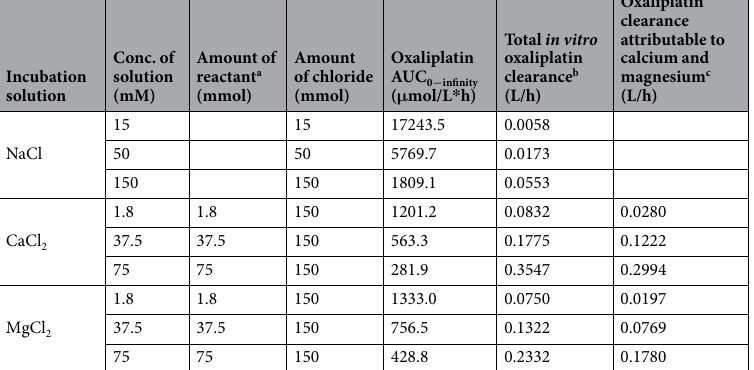
Table 2. Calculation of the in vitro intrinsic clearance of oxaliplatin attributable to chloride-, calcium-, and magnesium-mediated oxaliplatin degradation. The in vitro learance of oxaliplatin was calculated by non- compartmental analysis of oxaliplatin concentration versus time data from in vitro incubations with different concentrations of each ion solution. The amount of oxaliplatin added to the incubation solutions was 100 µ mol. a Reactant: calcium ions in CaCl b Total oxaliplatin clearance as calculated by non- 2 , magnesium ions in MgCl 2 . compartmental pharmacokinetic analysis: clearance = amount of oxaliplatin per unit volume/AUC 0-infinity . c Oxaliplatin clearance attributable to chloride, calcium and magnesium: Total in vitro oxaliplatin clearance minus the clearance attributable to 150 mmol of chloride (0.0553).